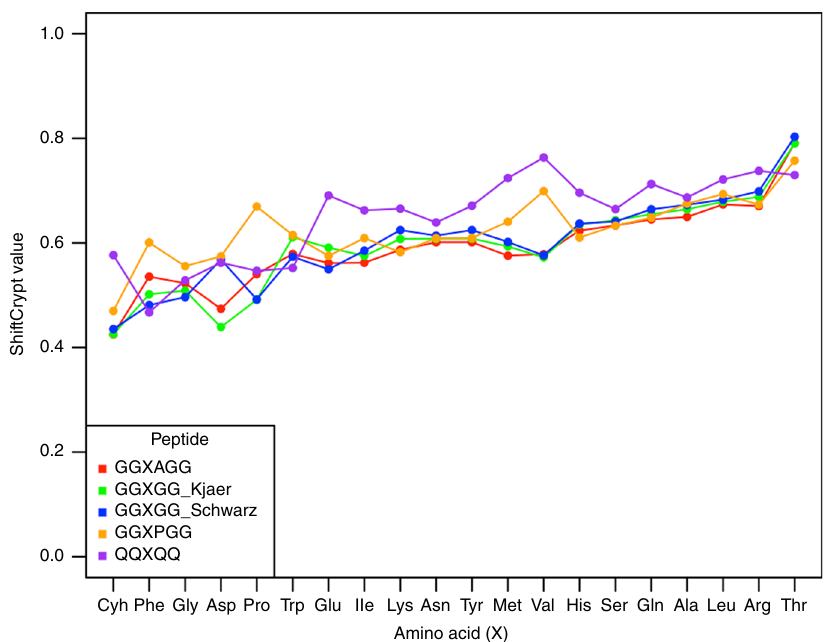
Fig. 6 ShiftCrypt index for a series of random coil peptides. The amino acids are ordered by increasing average ShiftCrypt value over all peptides. The GGXPGG and GGXAGG peptides come from ref. 16 , the QQXQQ from ref. 17 , the GGXGG schwarz, and the GGXGG Kjaer from refs. 15,21 ,